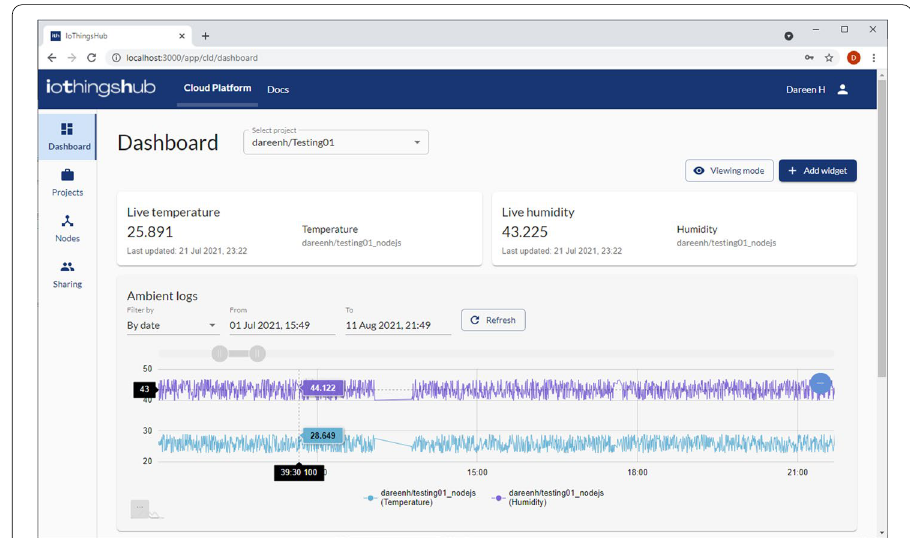
Fig. 14 IoThingsHub—an example of a project’s dashboard page